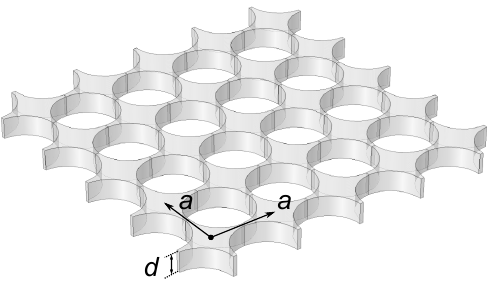
Figure 1. A schematic of a 2D hole array phononic crystal with dimensions d = 300 nm, a = 1 µ